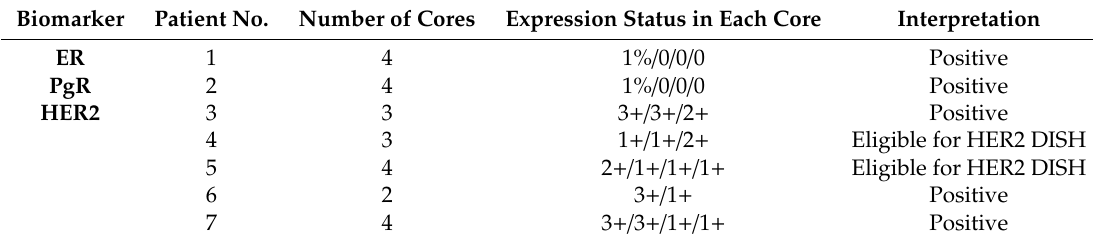
Table 2. Cases of invasive breast carcinoma in the presence of heterogeneous expression of surface hormone receptors and